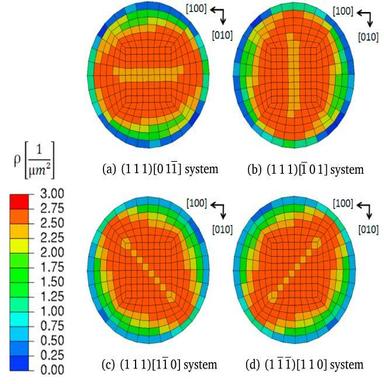
Accumulation of total dislocation density on a section perpendicular to the shaft's torsion axis and on four different slip systems.